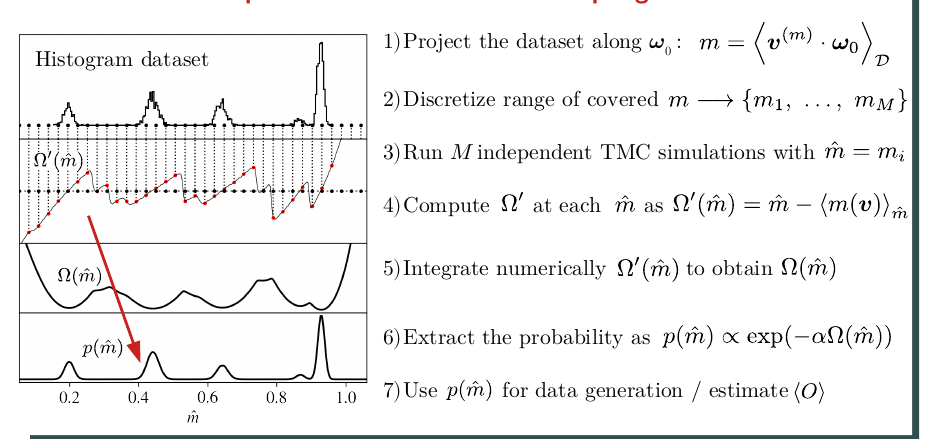
Figure 2: We describe the basic steps of the TMC sampling procedure, which can be used either to generate equilibrium samples of the model or to estimate the log- likelihood gradient during